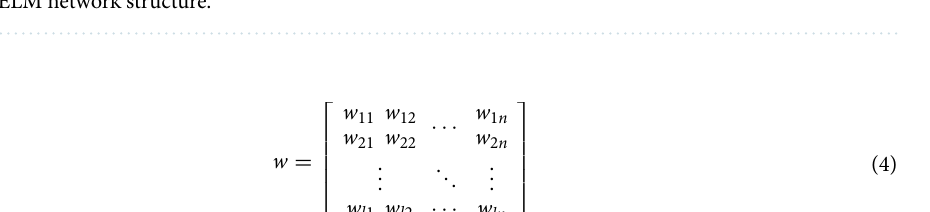
Figure 5. ELM network